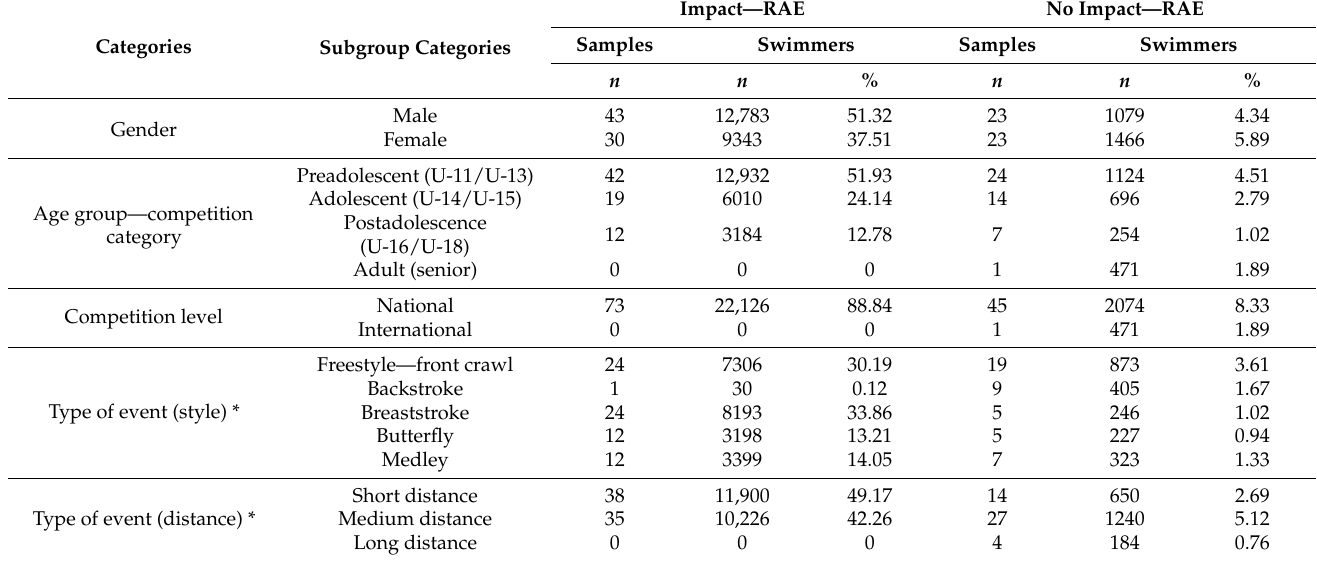
Table 4. Summary of samples ( n ) and swimmers ( n and %) with regard to the relationship between the RAE and short-term competition performance by sample characteristics (gender and age group), sport context (competition category and competition level), and type of event (style and